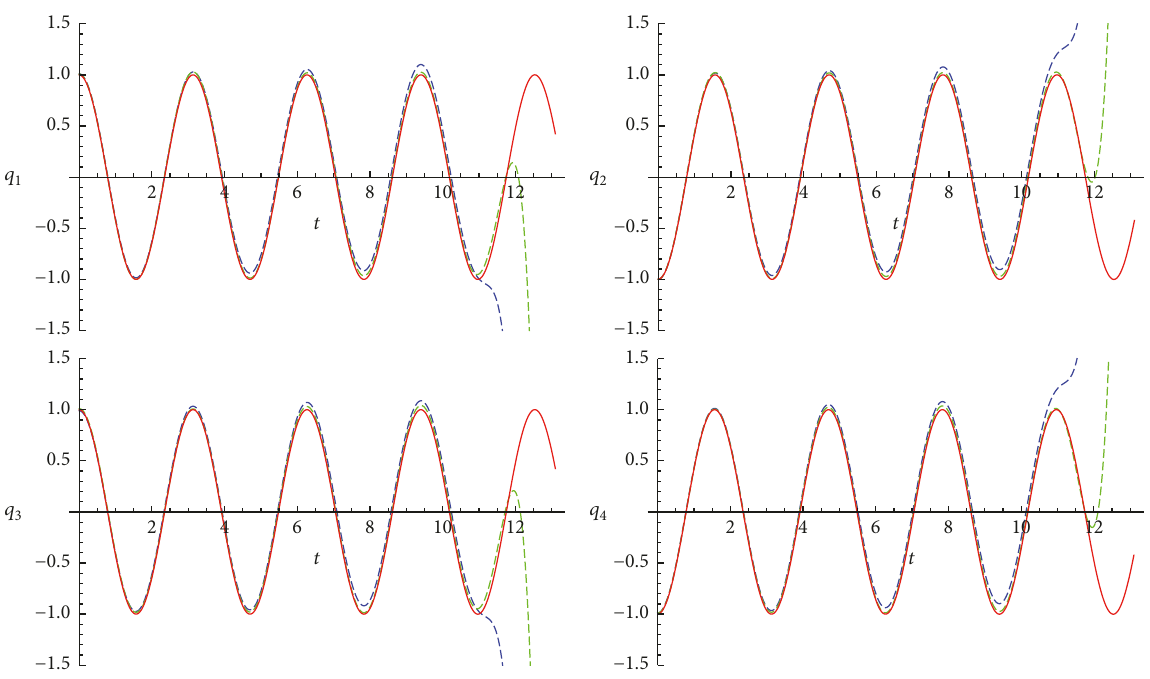
Figure 2: The curves of solutions of (5): the red curve is an approximate 𝜋 -periodic solution starting from 𝑃 2 , while the blue dashed curve and the green dashed curve are the reference solutions starting from 𝑄 21 and 𝑄 22 , respectively.